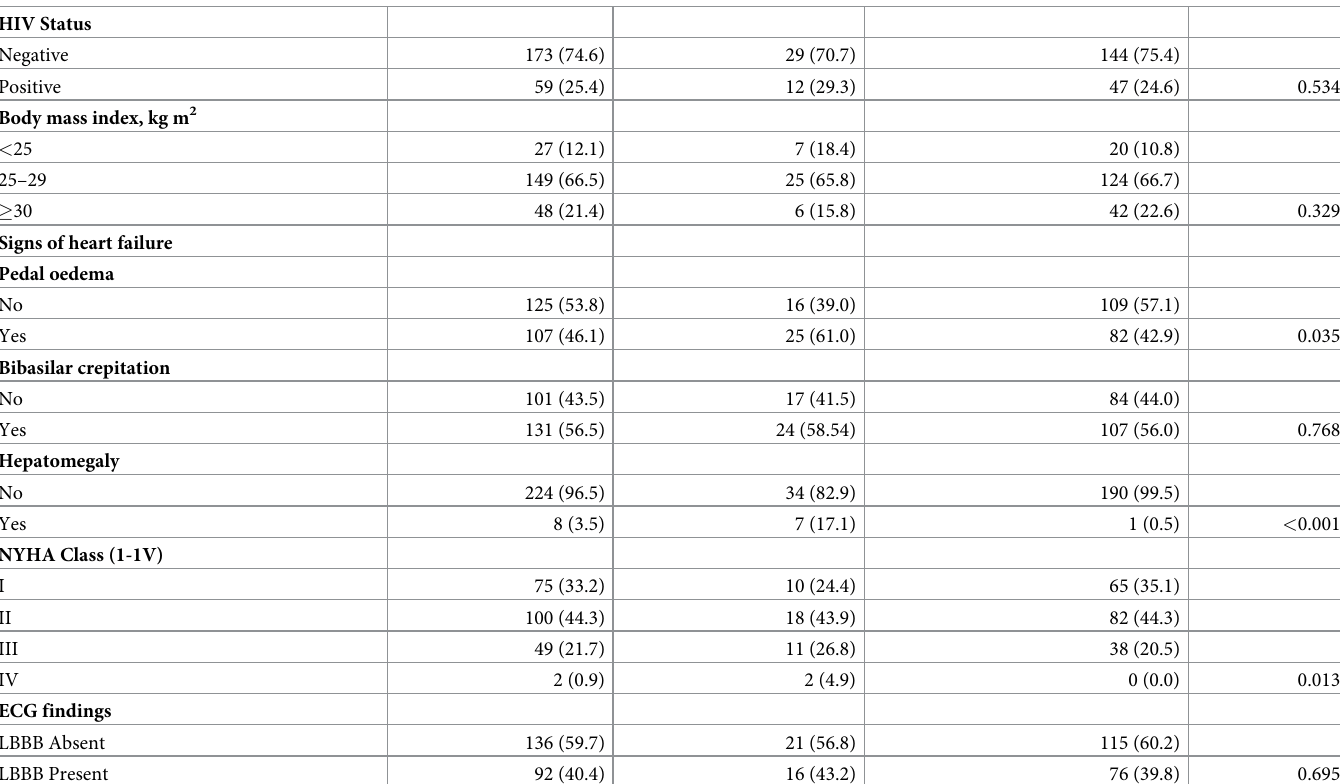
Individually, four (9.8%) patients were in NYHA functional class III and IV and 22 (53.7%) patients had incomplete recovery of LV function at six-month follow-up period. Full recovery of the left ventricular function occurred in 19 (46.3%) patients. No maternal or foetal mortality was documented at the six-month follow-up time